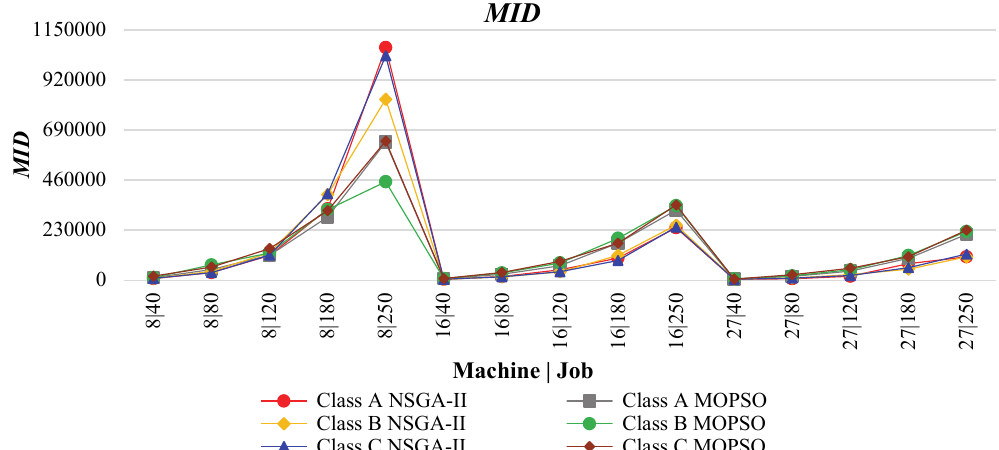
Fig. 18 MID criterion for the two algorithms in the medium and large scale sample problems